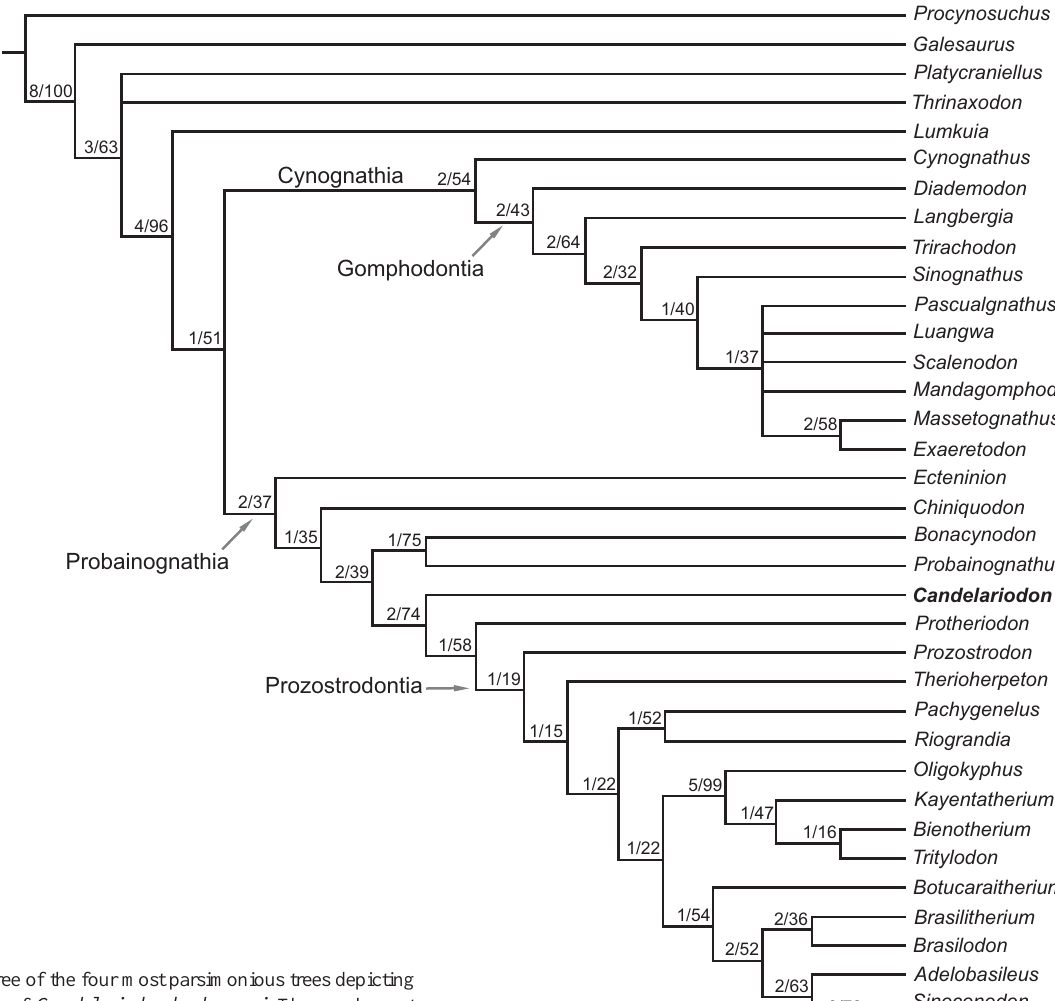
Fig. 7. Strict consensus tree of the four most parsimonious trees depicting the phylogenetic position of Candelariodon barberenai . The numbers at nodes indicate Bremer support and bootstrap values,